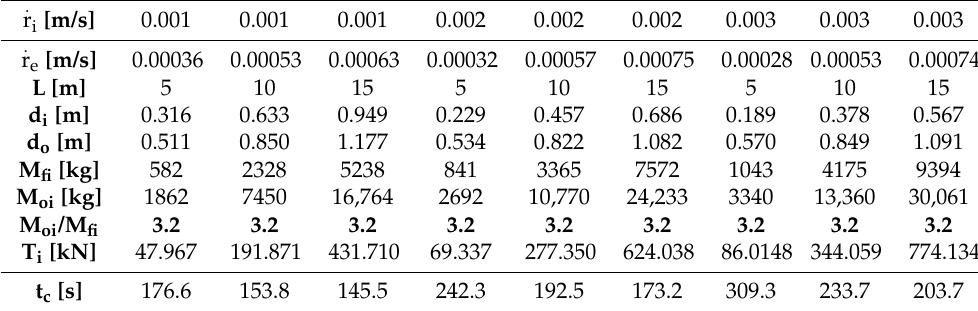
Table 7. Numerical results for R TM,i = 2 and imposed L,